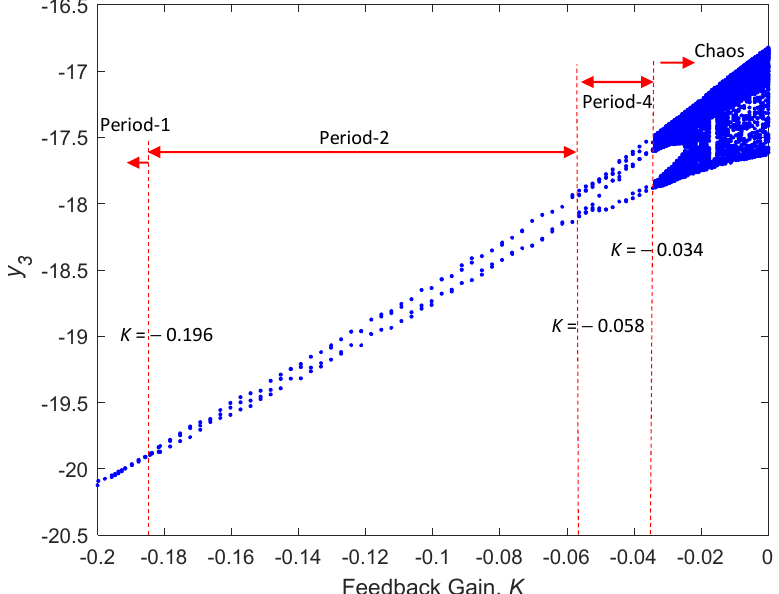
Figure 12. Bifurcation diagram of controlled system under ρ + ρε sin ω t , δ + δε sin ω t , and η + ηε sin ω t .